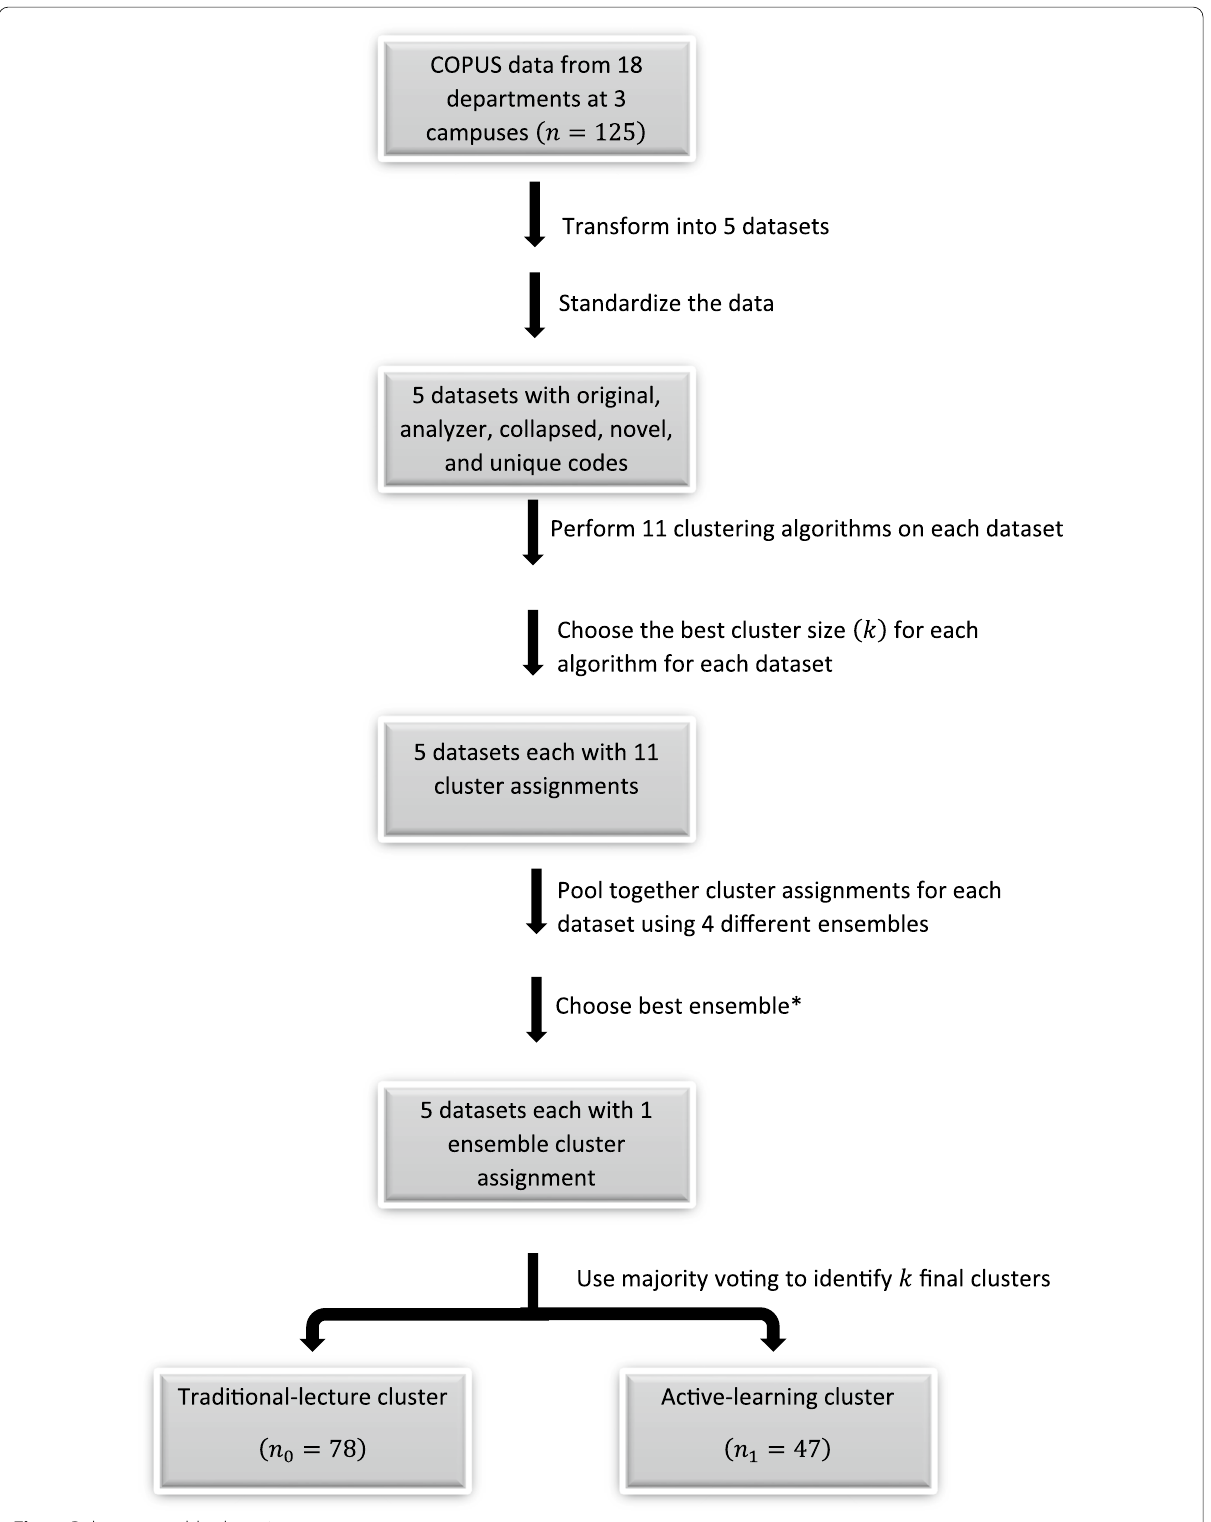
Fig. 1 Robust ensemble clustering